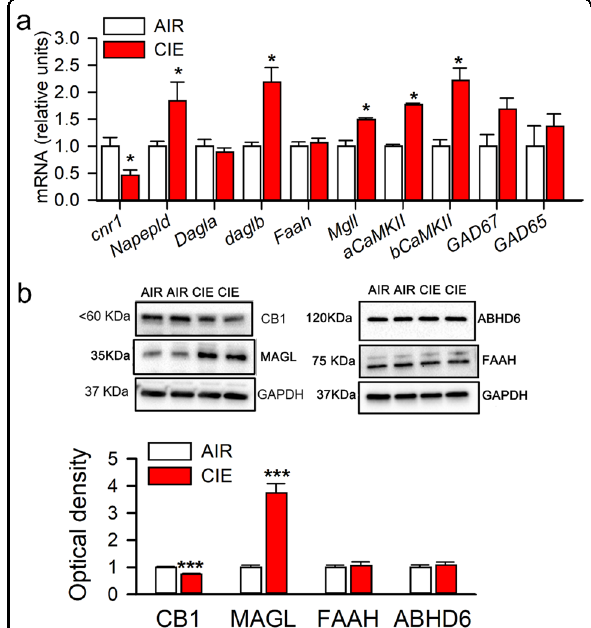
Fig. 2 Effects of chronic intermittent ethanol exposure on endocannabinoid-related gene and protein expression in the LHb. Adult male Long-Evans rats were intermittently exposed to either ethanol vapor (CIE) or air (Air) for 8 weeks. The LHb tissue was harvested at 24 h after vapor off. The mRNA levels of genes associated with endocannabinoid signaling including Cnr1, Napepld, Dagla, Daglb, Faah, Mgll , as well as genes related to excitatory and inhibitory neurotransmission, like aCaMKII, bCaMKII, Gad67 , and Gad65 were measured in CIE ( n = 11) and air control (Air, n = 6) rats. The protein levels of CB1Rs, MAGL, FAAH, and ABHD6 in the LHb were also measured. Panels ( a ) and ( b ) display quantitative mRNA levels and protein expression in these two groups. The Western blot and RT- qPCR tests were repeated three times. All data are expressed as mean ± SEM. * p < 0.05, ***, p < 0.001, CIE vs. Air group revealed by an unpaired t